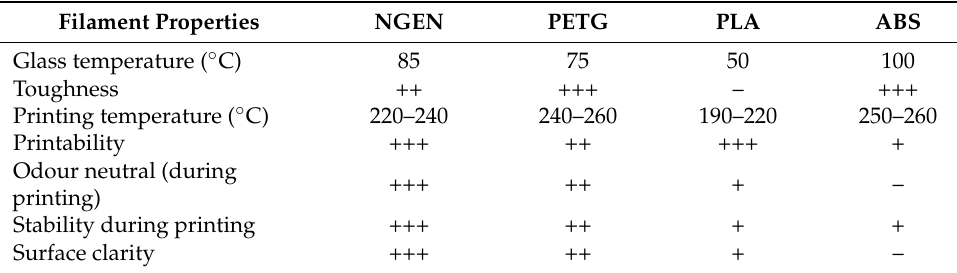
without a heated chamber or printing plate. Table 1. Comparison of properties of filaments used